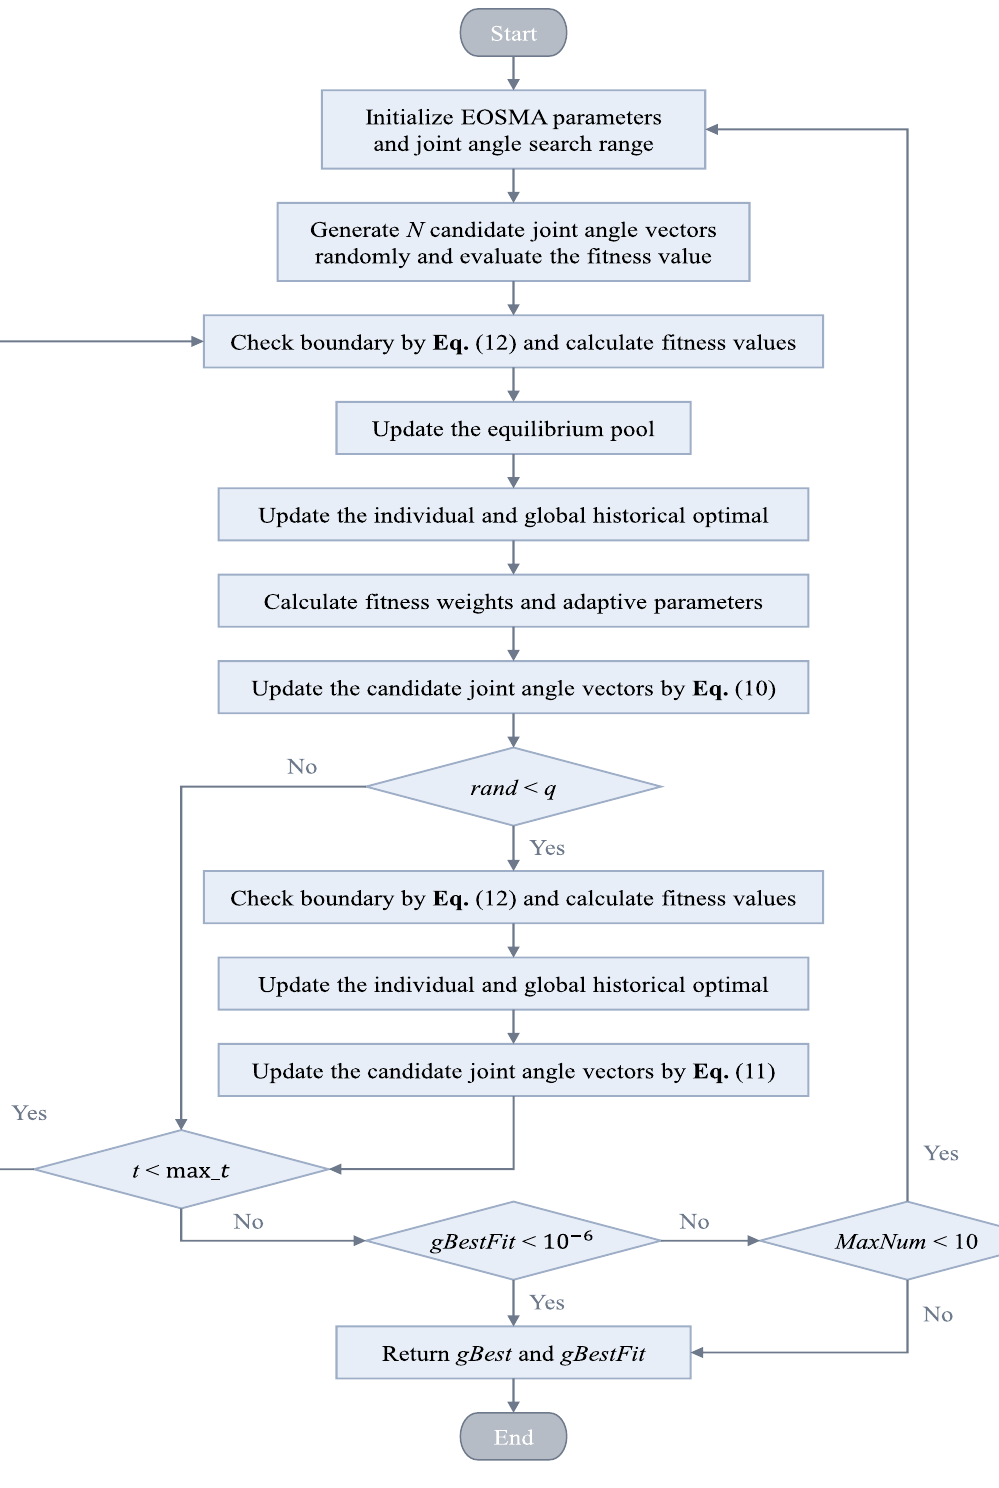
Figure 6. Flow chart of the EOSMA implementation for the IK